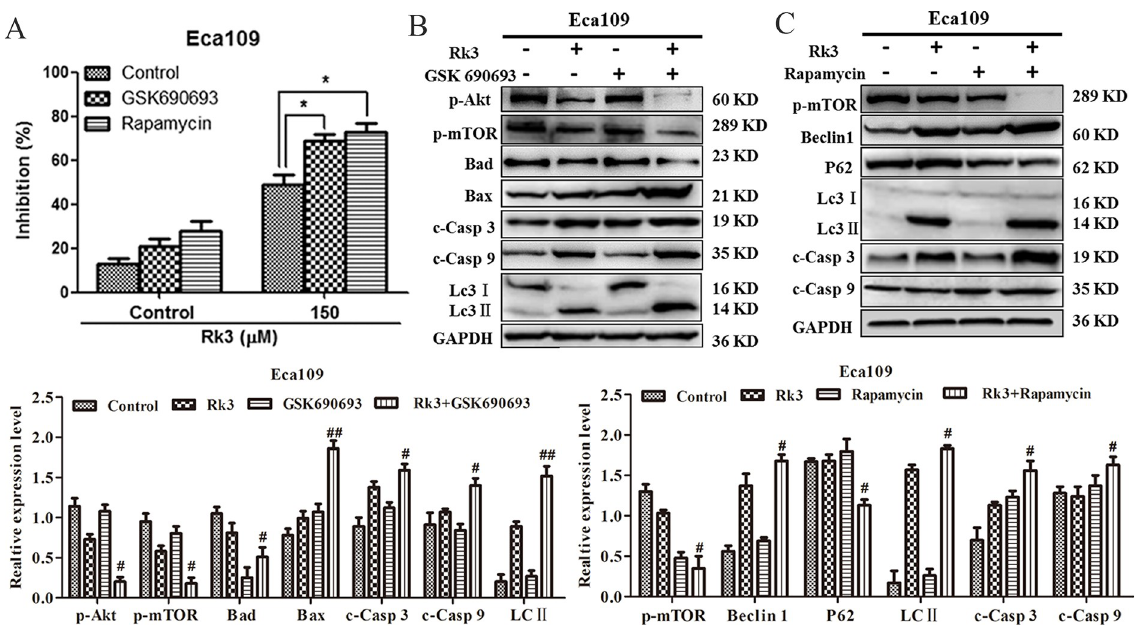
Fig 6. Rk3 induces apoptosis and autophagy by blocking the PI3K/Akt/mTOR pathway in esophageal cancer cells. (A) Cells were pretreated with GSK690693 (25 nM) or rapamycin (50 nM) for 2 h and then incubated with 150 μ M Rk3 for 24 h. The inhibition of cell proliferation was detected using MTT assays. (B) and (C) The expression of apoptosis- and autophagy-related proteins was analyzed by western blotting after pretreatment with inhibitors. Cells were treated as stated above. � p < 0.05 compared with the control; # p < 0.05, ## p < 0.01 compared with the Rk3-treated